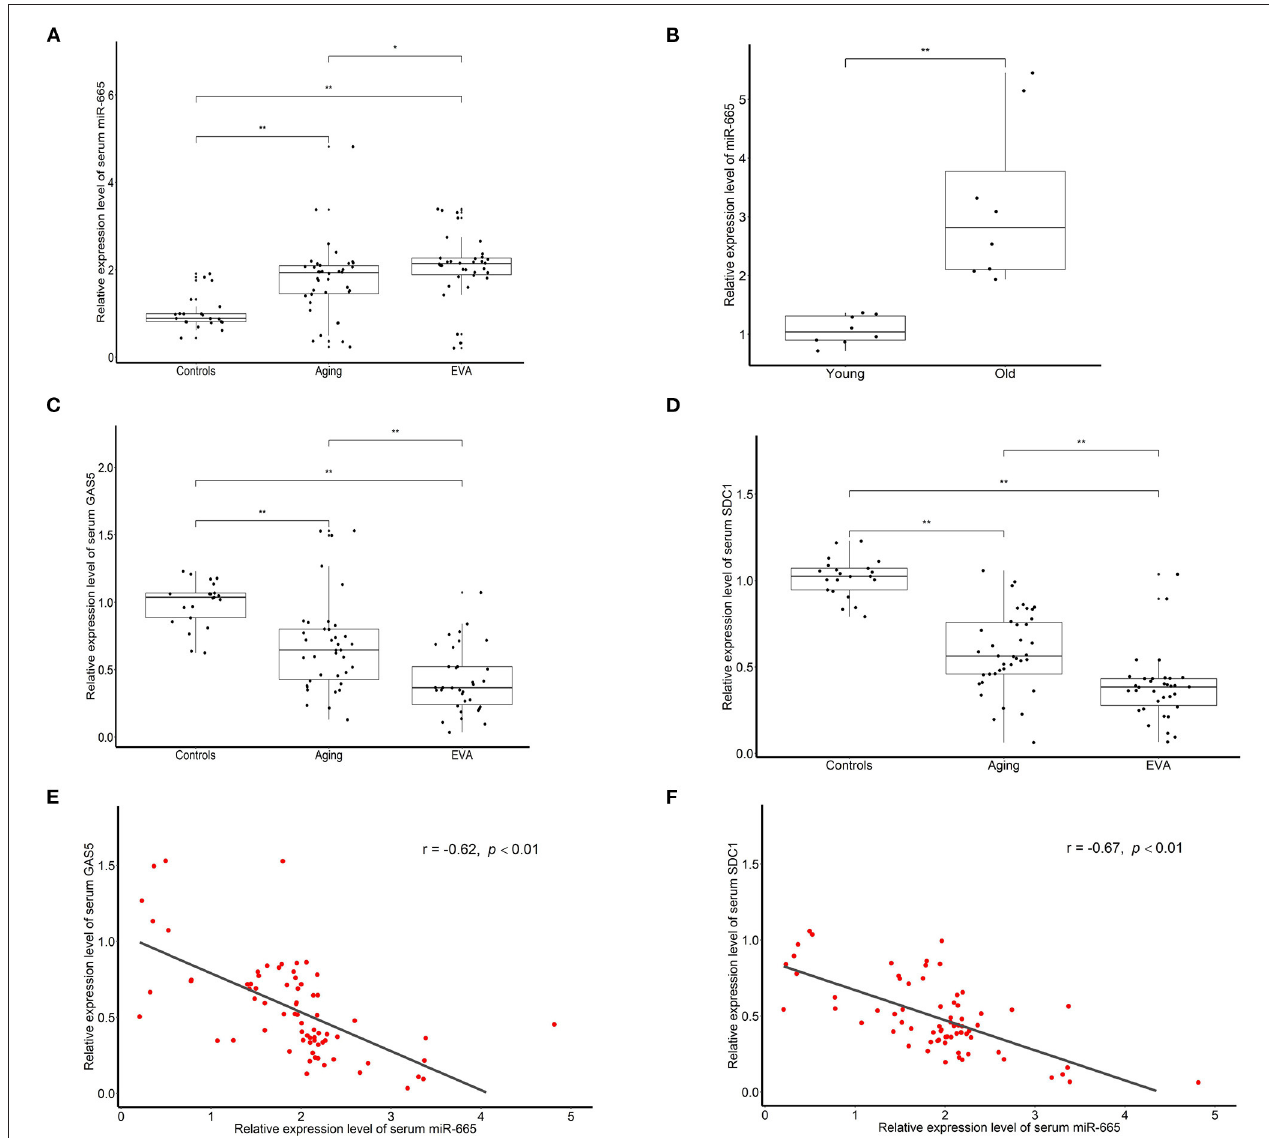
FIGURE 5 | Serum level of miR-665 is higher and is negatively correlated to lncRNA GAS5 and SDC1 in the aging and EVA groups. (A) qRT-PCR assays of miR-665 for serum samples of aging, EVA, and control individuals. * P < 0.05, ** P < 0.01. (B) qRT-PCR assays of miR-665 in the media of central arteries of young and old rats. ** P < 0.01. (C) qRT-PCR assays of lncRNA GAS5 for serum samples of aging, EVA, and control individuals. ** P < 0.01. (D) qRT-PCR assays of SDC1 for serum samples of aging, EVA, and control individuals. ** P < 0.01. (E) Pearson correlation analysis of serum miR-665 and serum lncRNA GAS5 in individuals with aging and EVA. r = − 0.62, P < 0.01. (F) Pearson correlation analysis of serum miR-665 and serum SDC1 in individuals with aging and EVA. r = − 0.67, P <